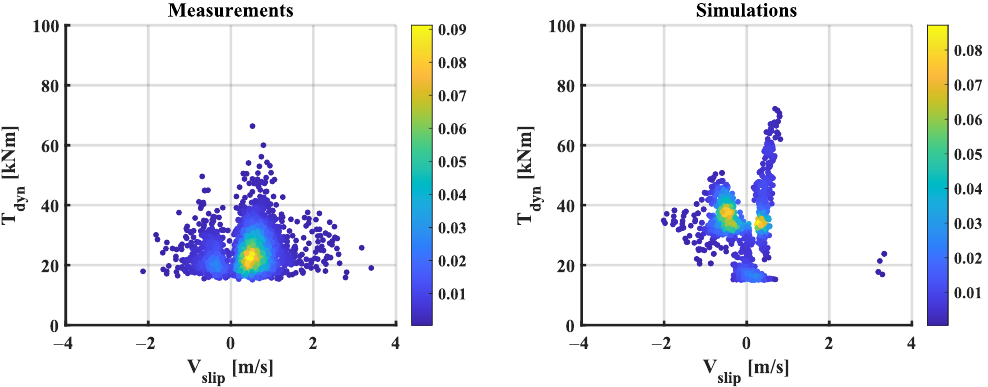
Figure 13. Comparison between Simulation and Measurement results. Dynamic torque vs. slip velocity during traction and braking process, provoked by different adhesion